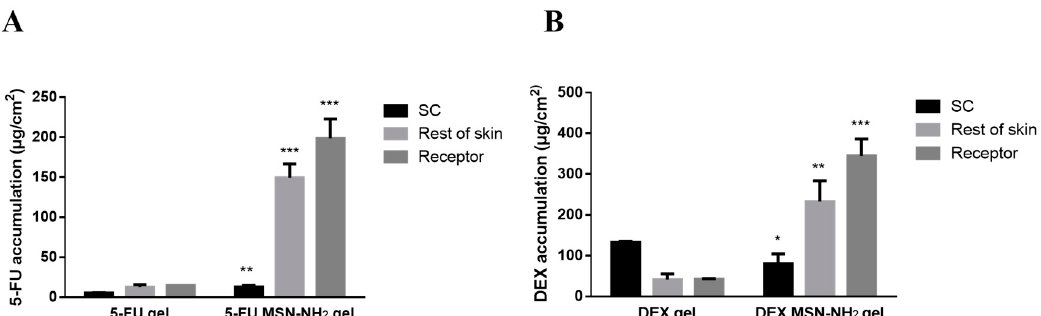
Figure 9. 5-FU ( A ) and DEX ( B ) accumulation in different skin layers and receptor media when delivered by MSN-NH2 and free in gel. Data are represented as mean ± SD ( n = 3). Statistical significance was obtained with p -values ≤ 0.05 , where * p ≤ 0.05, ** p ≤ 0.01, *** p ≤ 0.001.